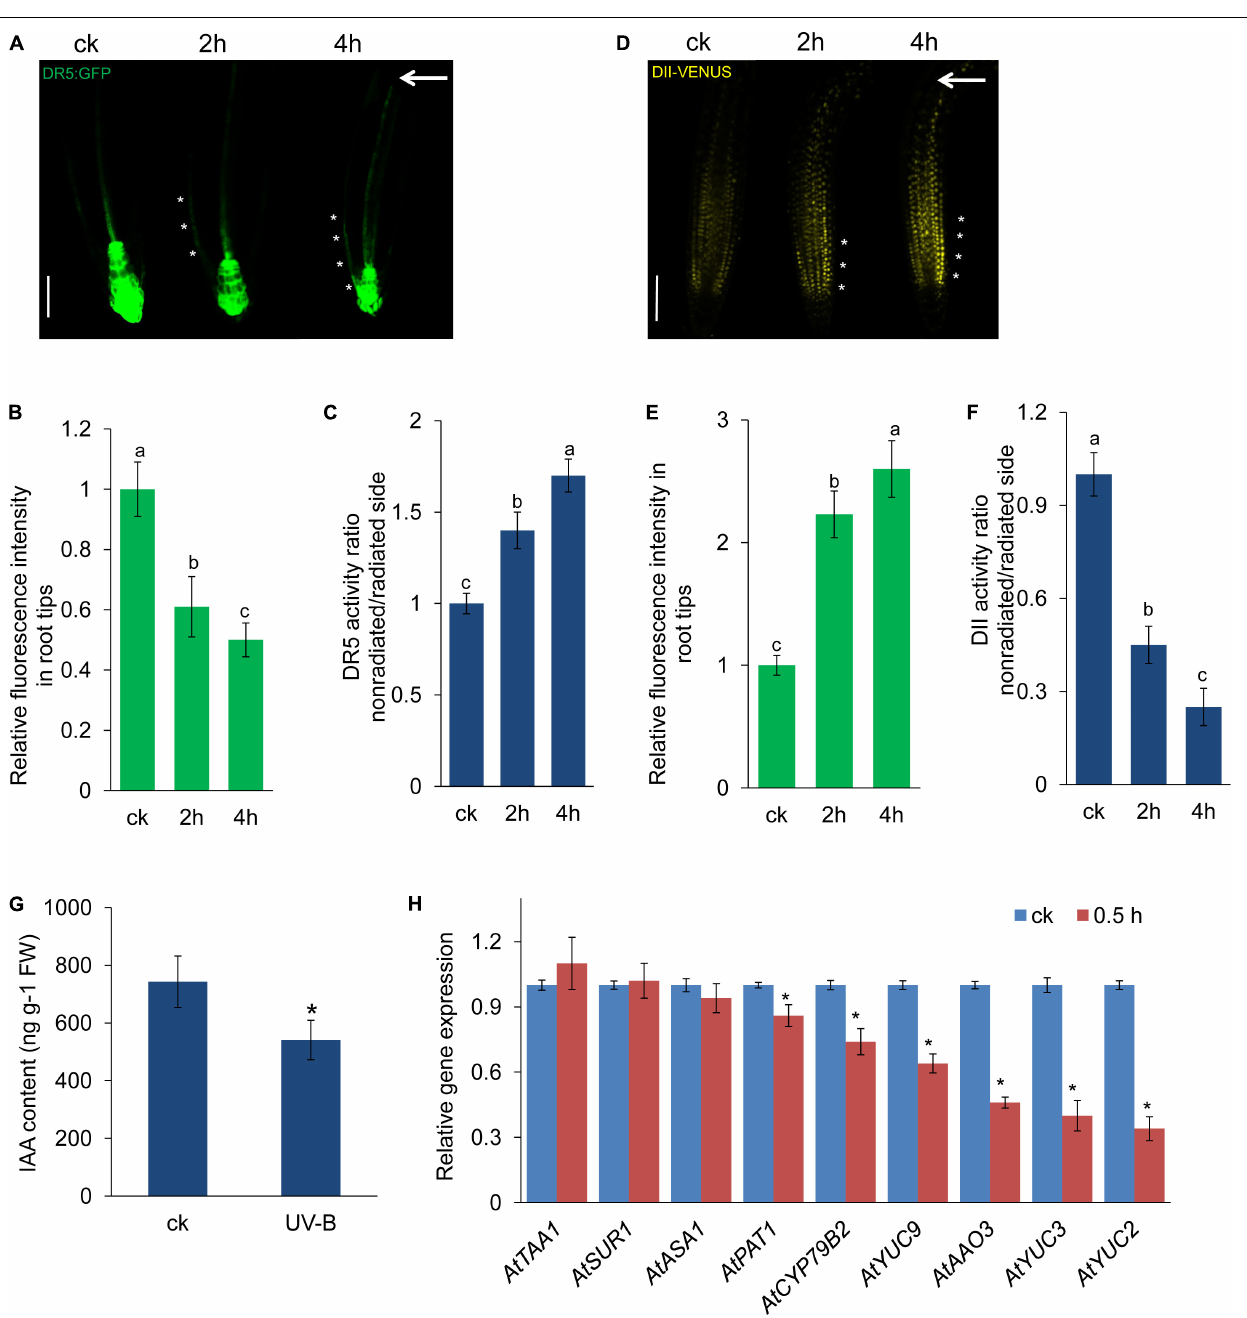
Frontiers in Plant Science |